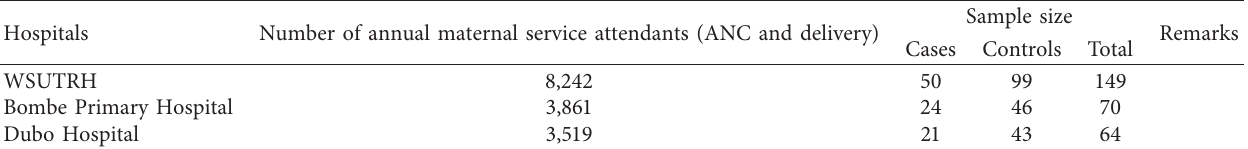
Table 2: Sample size allocations for the selected hospitals, Wolaita zone, 2019 (Wolaita Zone Health Department Annual Report,